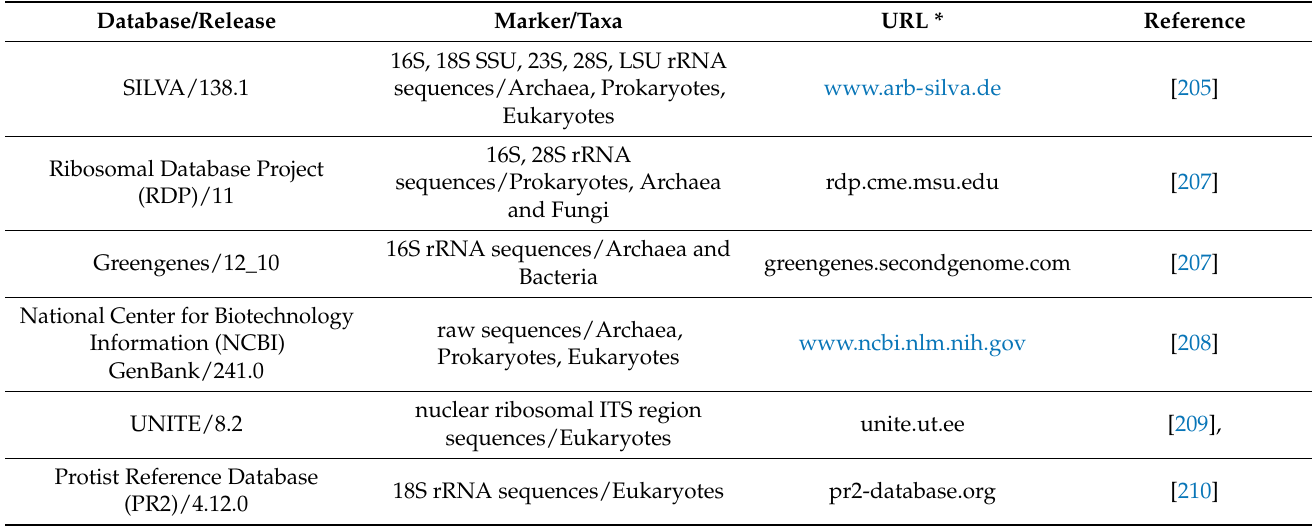
Table 6. List of the main reference databases used for the taxonomic annotation of the representative sequences in metabarcoding studies of terrestrial microbial communities.